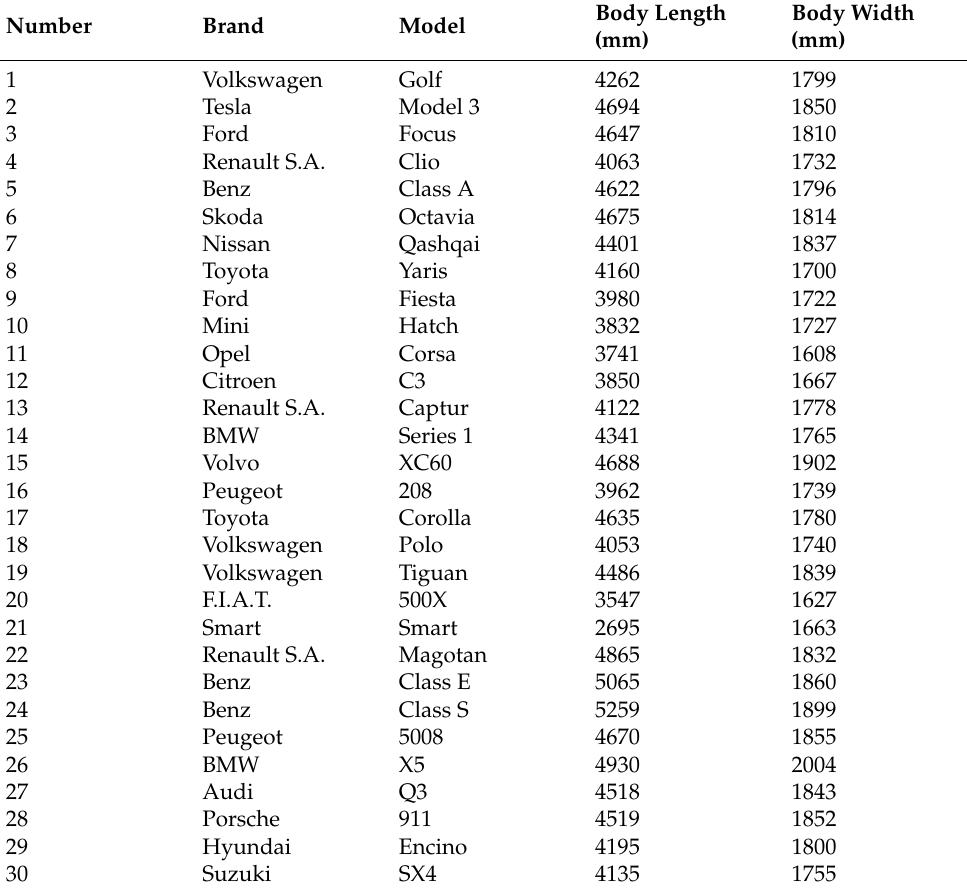
Table 1. Size information of the best-selling cars in the European